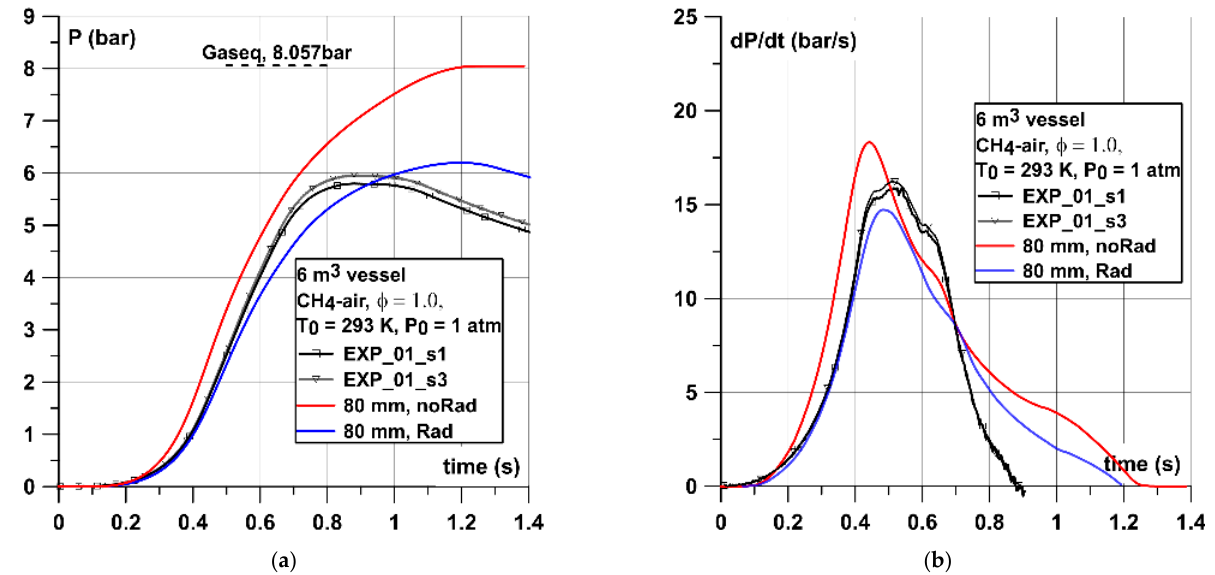
Figure 10. ( a ) Pressure and ( b ) dP/dt graphs for stoichiometric CH 4 –air mixture in 6 m 3 vessel. Grey lines show the experimental pressures recorded.